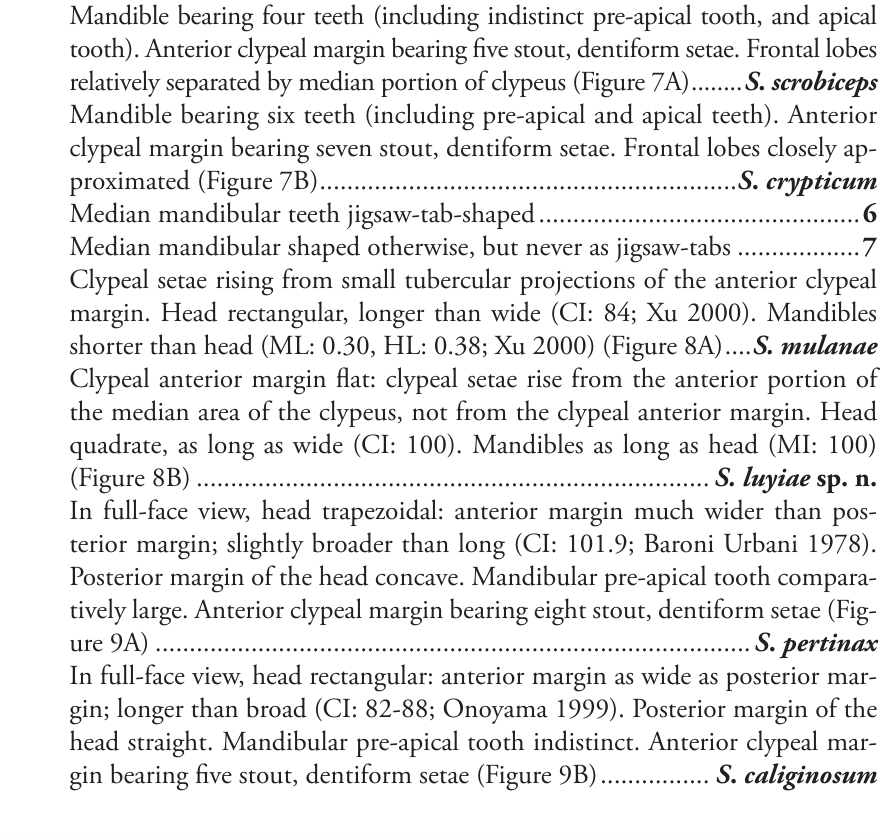
Figure 6. Stigmatomma sakaii and S. xui . Illustrations by FAE. A S. sakaii ; worker; full-face view B S. xui ; worker; full-face